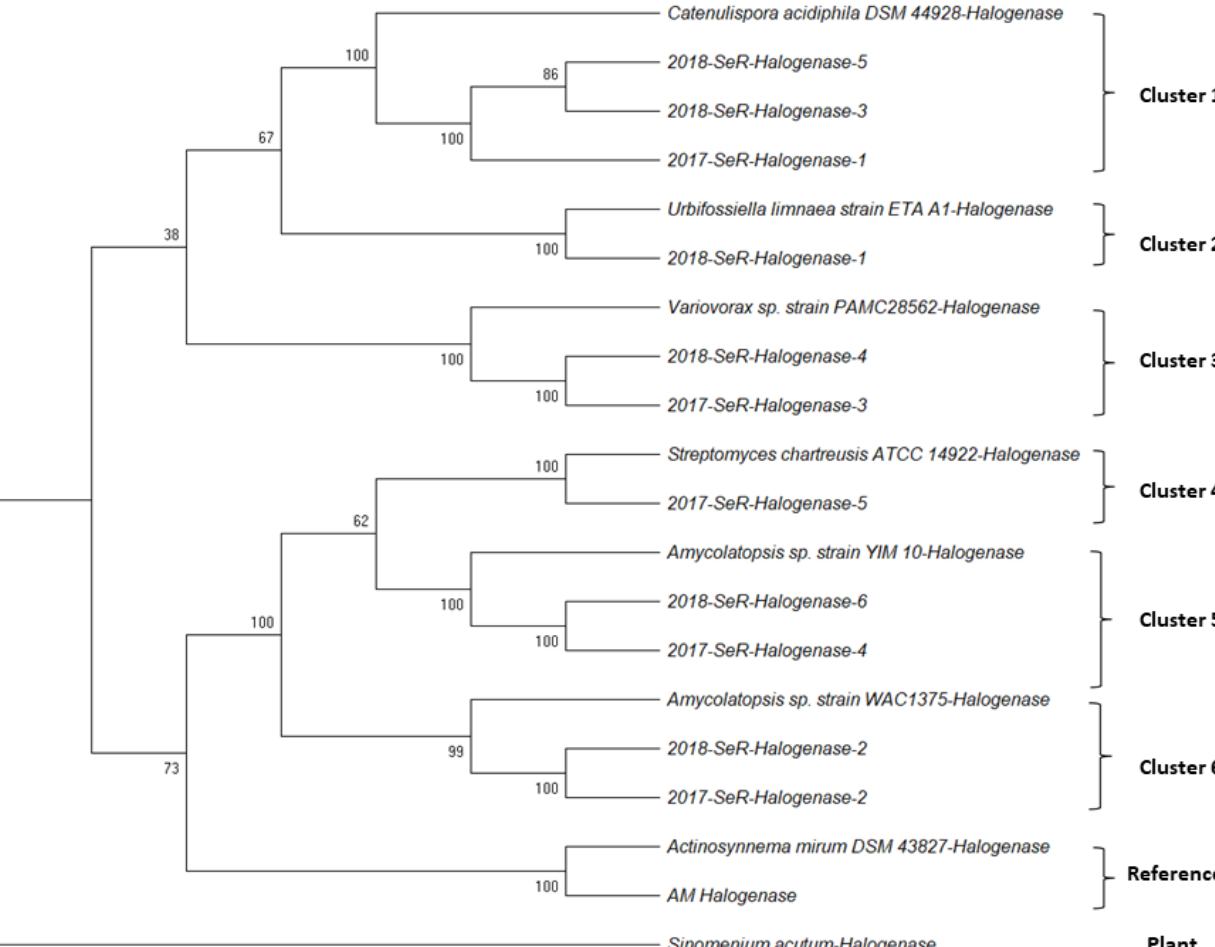
Figure 5. Phylogenetic tree of the obtained halogenase gene sequences from G. heterophylla, and homologous sequences from the NCBI database (https://www.ncbi.nlm.nih.gov/, accessed on 15 October 2021). This tree is deposited on the TreeBASE database (TreeBASE ID: Tr134221). Multiple alignments are performed using the Muscle tool, and the phylogenetic tree is generated using the UPGMA model from MEGA-X software (Version 10.0.4). The bootstrap values are shown on the branch based on 1000 pseudoreplicates. The distances of this evolutionary tree are calculated using the Maximum Composite Likelihood method. The halogenase gene from Sinomenium acutum is used as a plant gene.